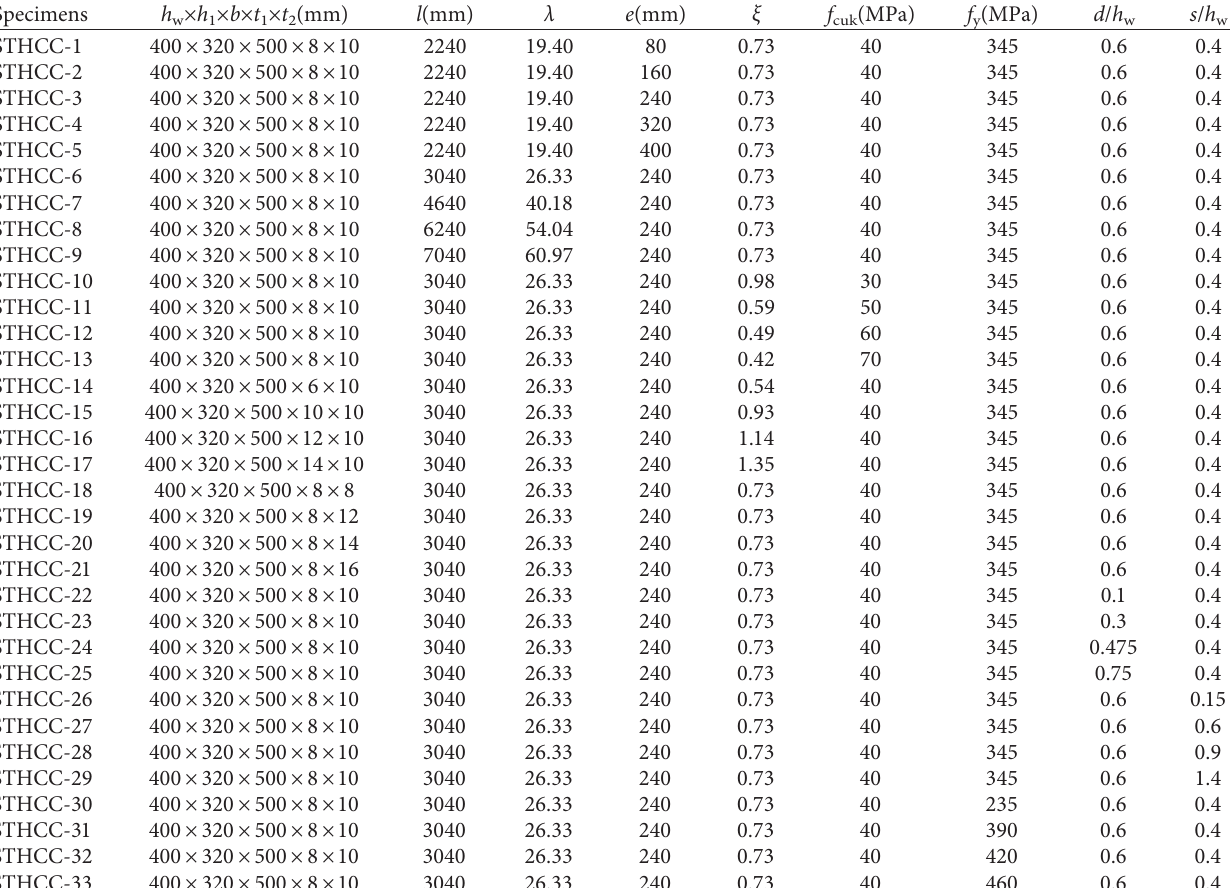
Figure 1: Physical meaning of all variables for STHCC specimens. (a) Longitudinal-section of STHCC specimens. (b) Cross section of STHCC specimens. Table 1: Specific parameters of 33 STHCC